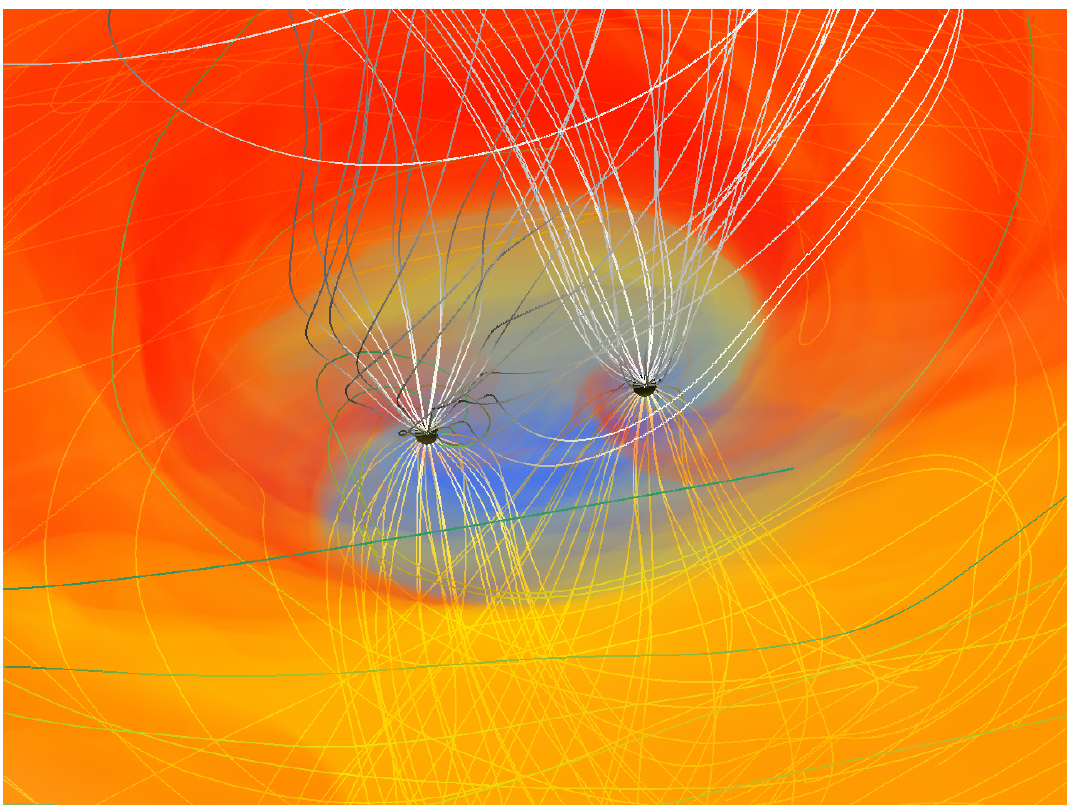
Figure 5. Rest-mass density (color scale) and magnetic field structure (white lines) of a fully relativistic GRMHD simulation in dynamical spacetime from